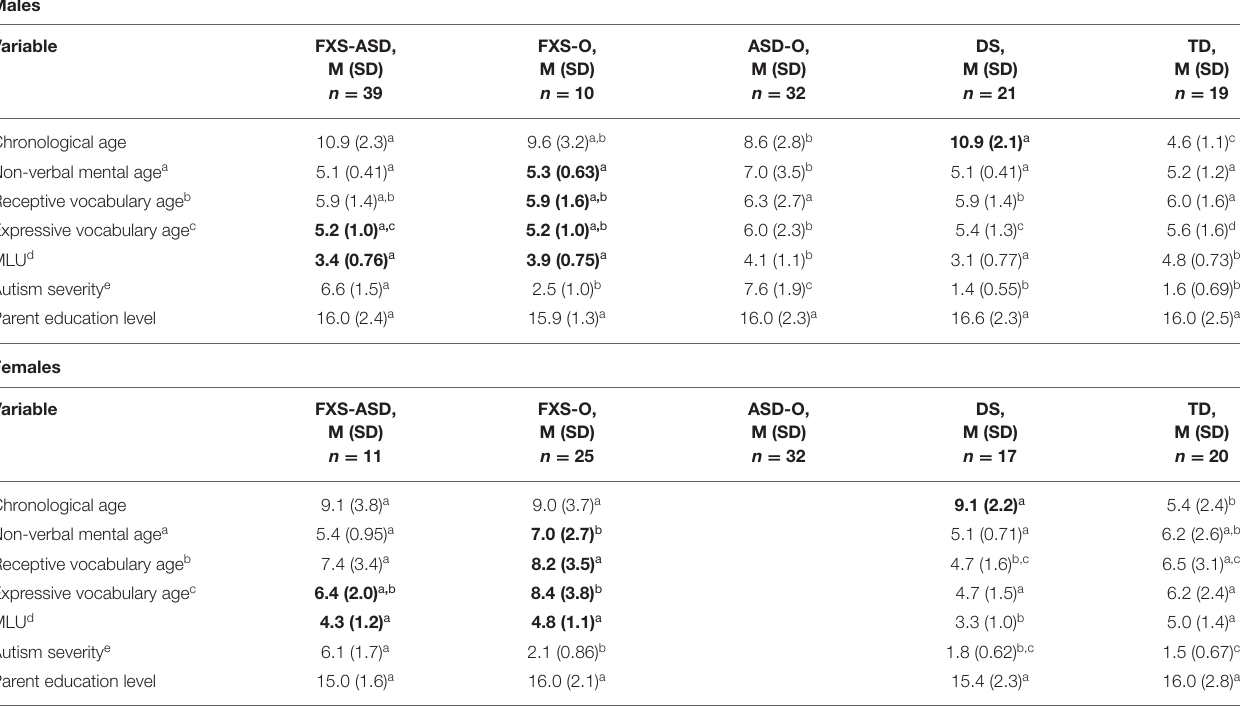
TABLE 1 | Participant